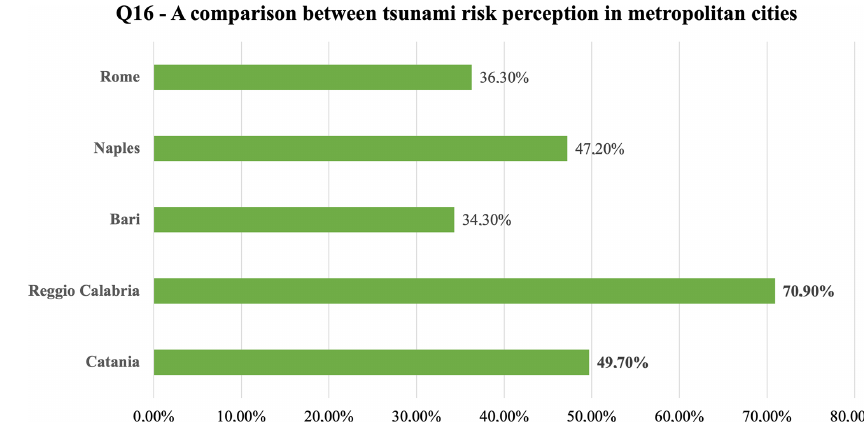
Figure 12. Tsunami risk perception (Q16): comparison between the metropolitan cities (“yes” answer percentages).